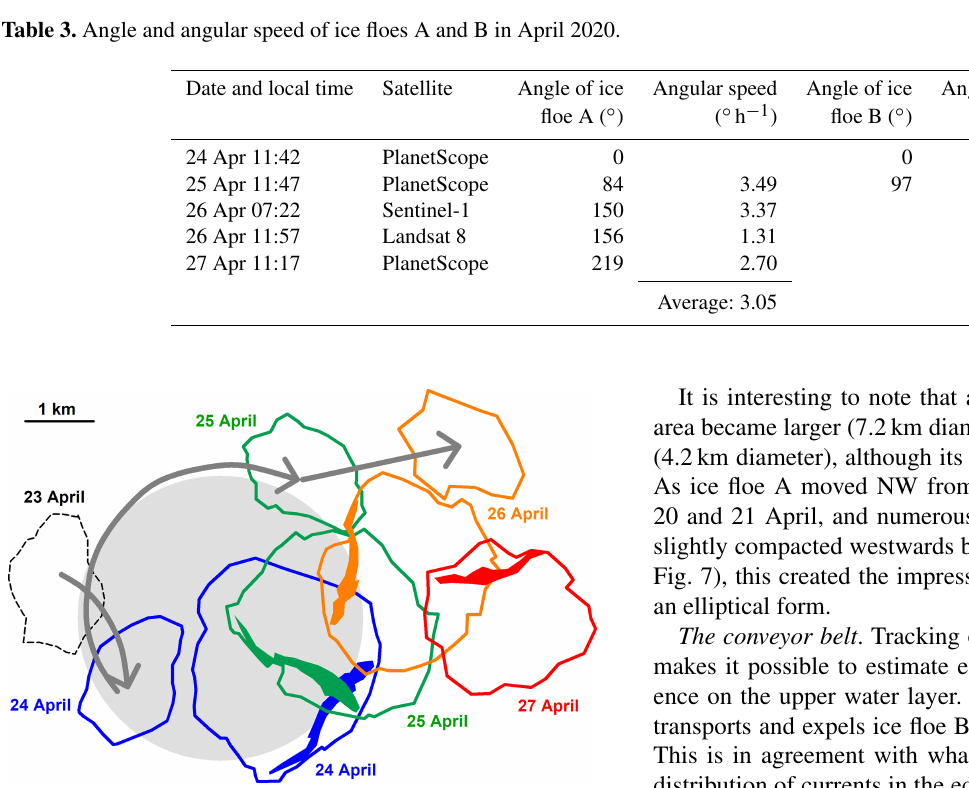
Figure 10. Schematic representation of position and displacement of ice floes A and B between 23 and 27 April 2020. Grey circle – approximate area affected by eddy, defined from ice ring outer limit on 15 April